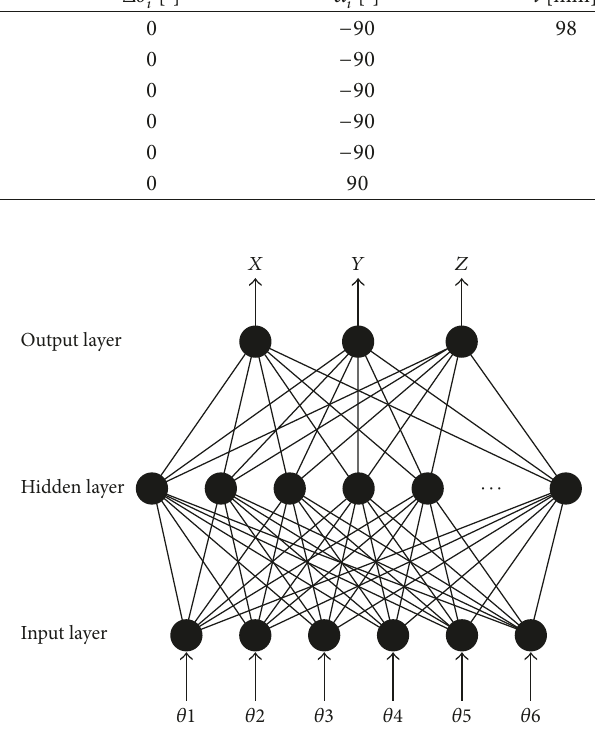
Figure 3: The structure of the kinematic model based on BPNN.